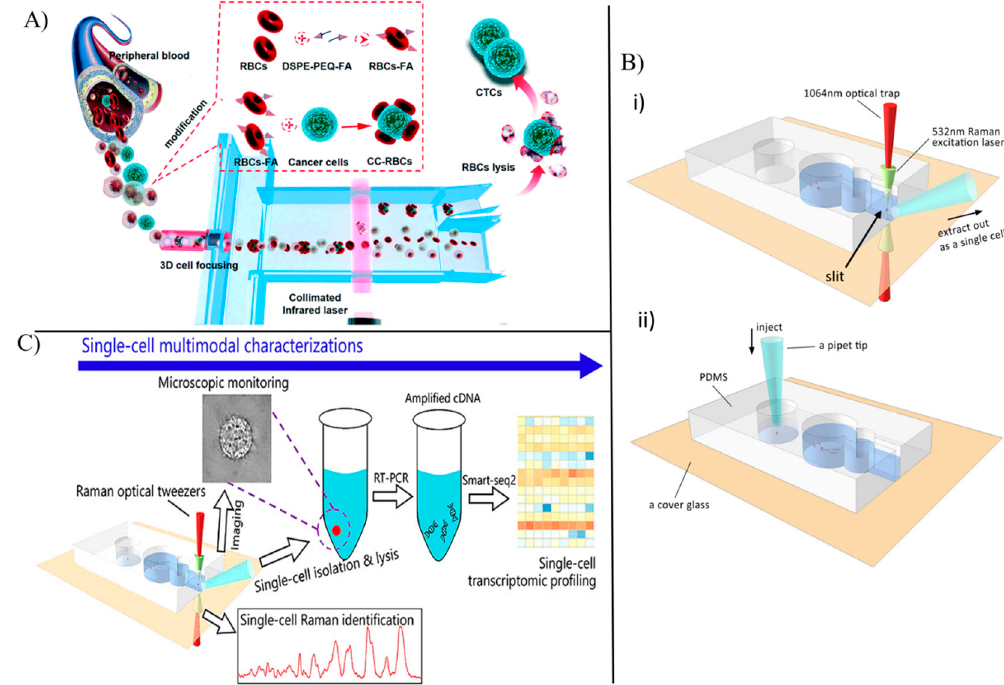
Figure 5. Optofluidic cell trapping ( A ) Optofluidic system showing modification of CTCs for their separation from RBCs based on differences in optical trapping constants (reproduced with permission from [94]). ( B ) Workflow of optofluidic system: (i) single cell is moved towards the slit (the stipe part of the hole) where ROT takes spectra, and (ii) isolated liquid from (i) is transferred to the circular zone to check for the presence of an isolated cell (adapted from [96]). ( C ) Schematic representation of the optofluidic system combining ROT for single cell Raman identification and single cell RNA sequencing (scRNA-seq) for the detection of drug sensitivity-related gene expression (reproduced with permission from [97]).